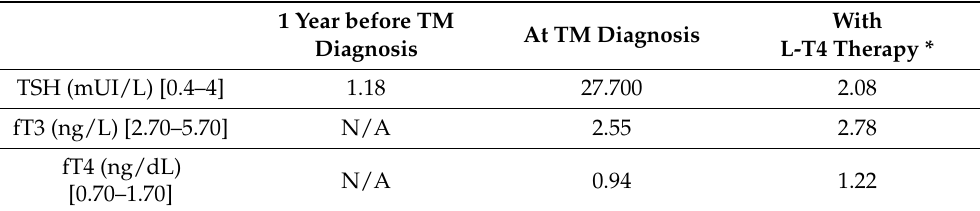
Table 1. Thyroid function test before, during and after the diagnosis and management of patient TM. 1 Year before TM With At TM Diagnosis Diagnosis L-T4 Therapy * TSH (mUI/L) [0.4–4] 1.18 27.700 2.08 fT3 (ng/L) [2.70–5.70] N/A 2.55 2.78 fT4 (ng/dL) N/A 0.94 [0.70–1.70]